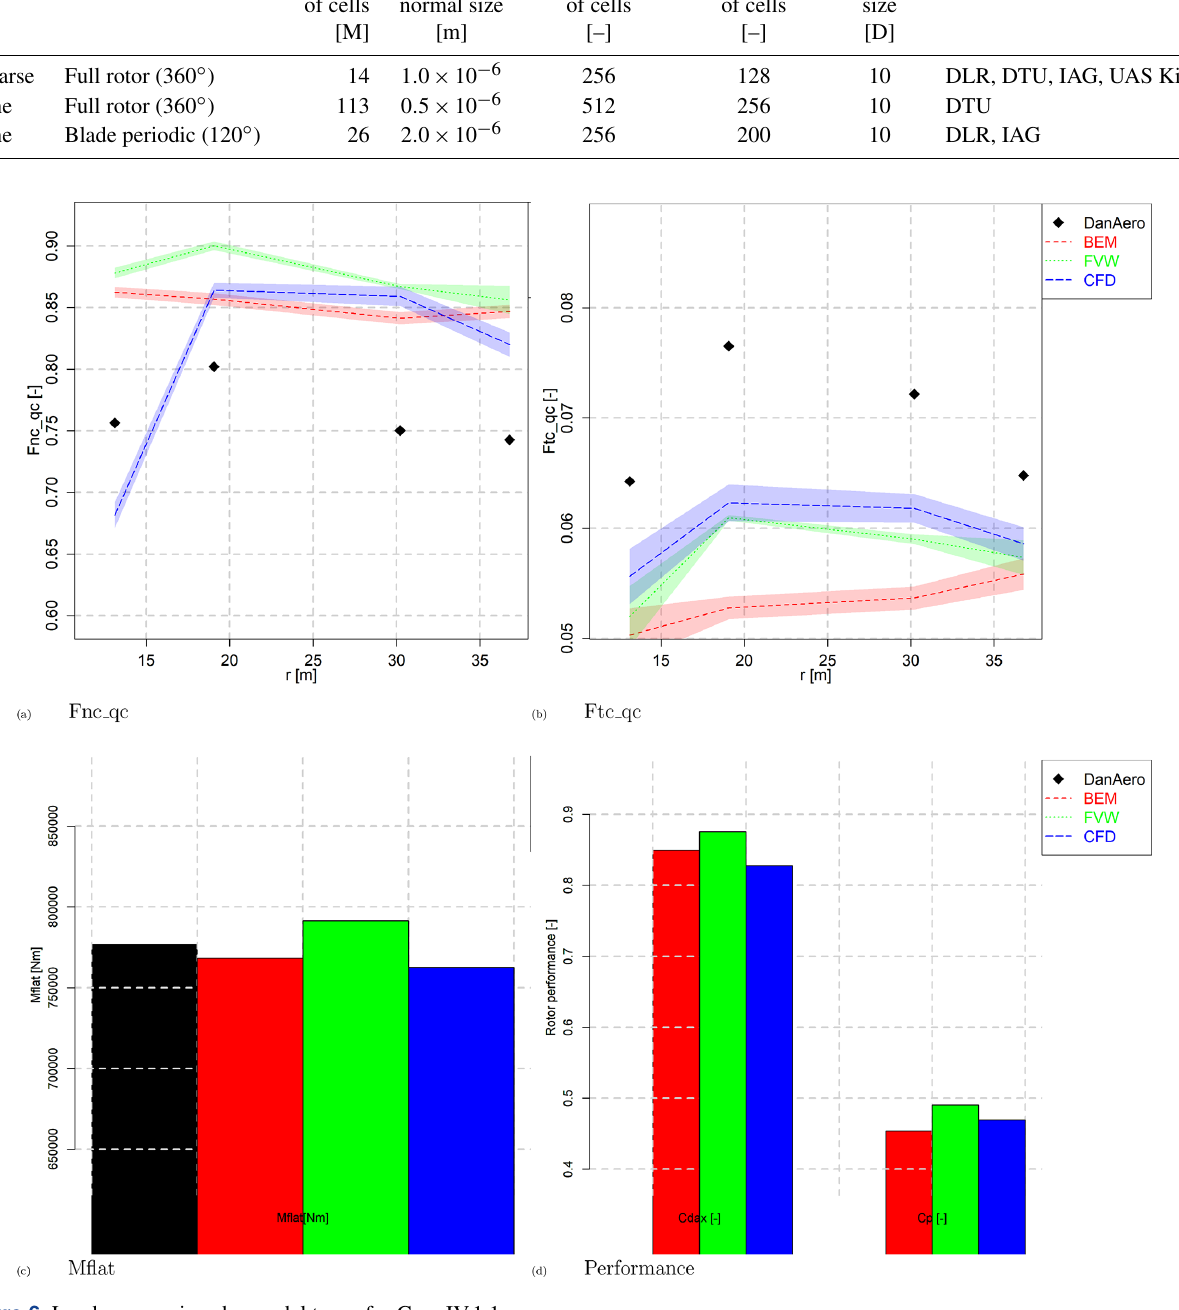
Figure 6. Loads comparison by model types for Case